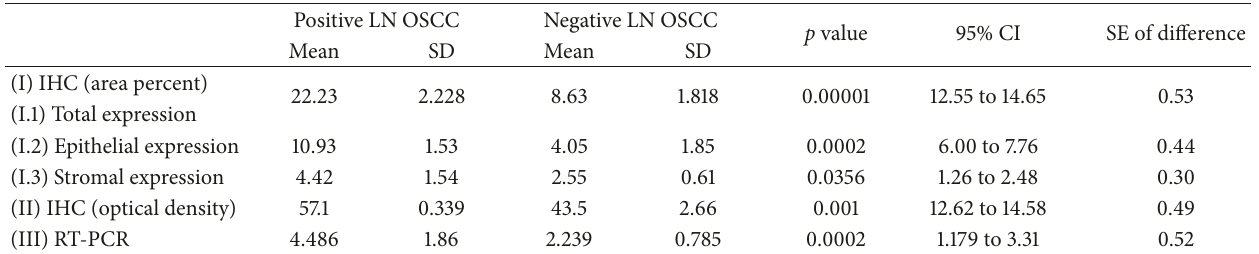
Figure 2: Photomicrographs showing negative immunoreaction of VEGF-C in normal mucosa ((a) × 200), weak positive VEGF-C expression in node-free OSCC ((b) × 200), and more diffuse positive expression in positive lymph nodes OSCC ((c) × 200), ((d) × 400). (d) shows VEGF-C expression by cancer associated fibroblasts (arrows) and blood endothelial cells (arrow heads). Table 2: Assessment of VEGF-C